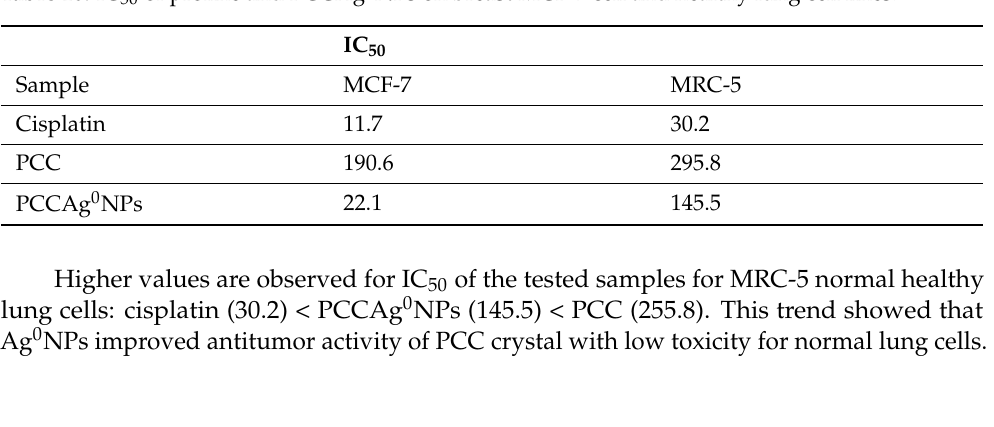
Figure 14. Concentration-dependent cytotoxicity curves for the tested single crystals for: ( a ) MCF-7 cell lines, ( b ) MRC-5 cell line. Table 10. IC 50 of proline and PCCAg 0 NPs on breast MCF-7 cell and healthy lung cell